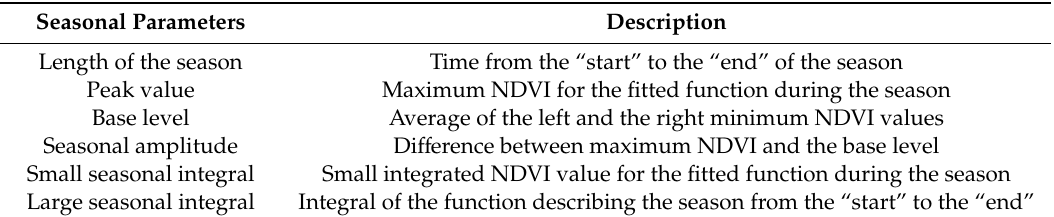
Table 3. Description of the seasonal parameters analyzed in the